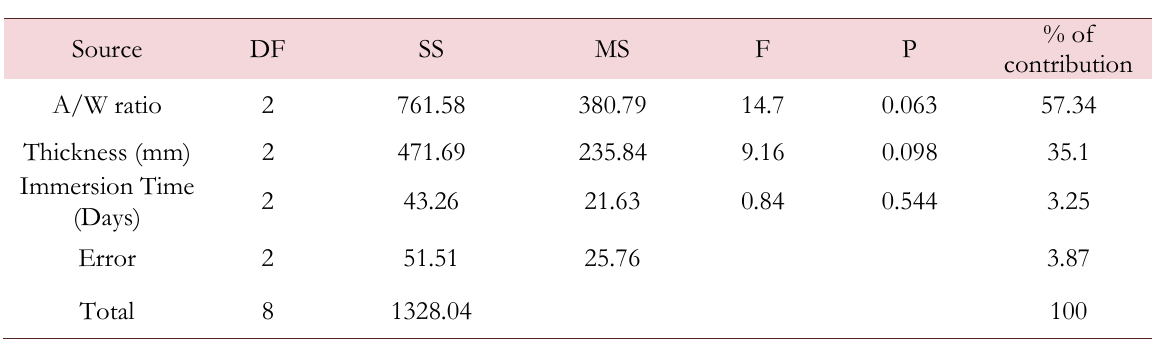
Table 6: ANOVA for Fracture toughness MPa